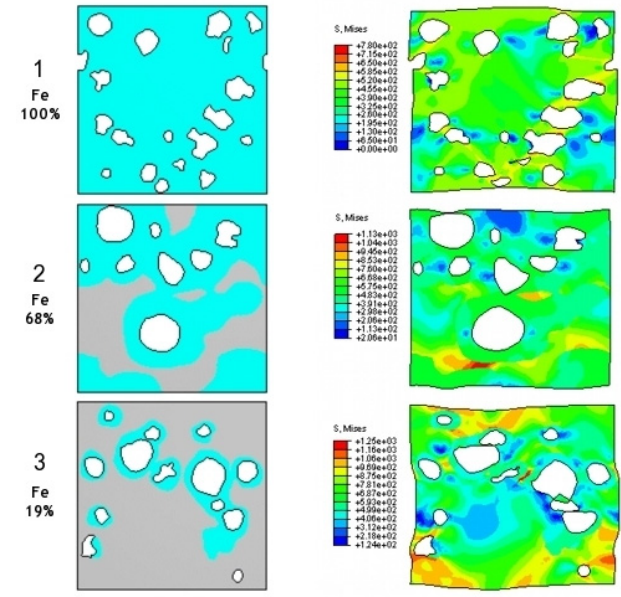
Figura 15: distribuzione dello sforzo in tre microstrutture eterogenea di ghisa nodulare simulate con modelli windowing a condizioni al contorno periodiche ( E q.